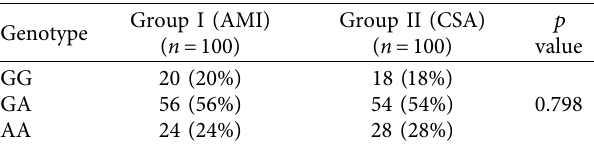
Table 8: Genotype distribution of -844G/A polymorphism for AMI and CSA.